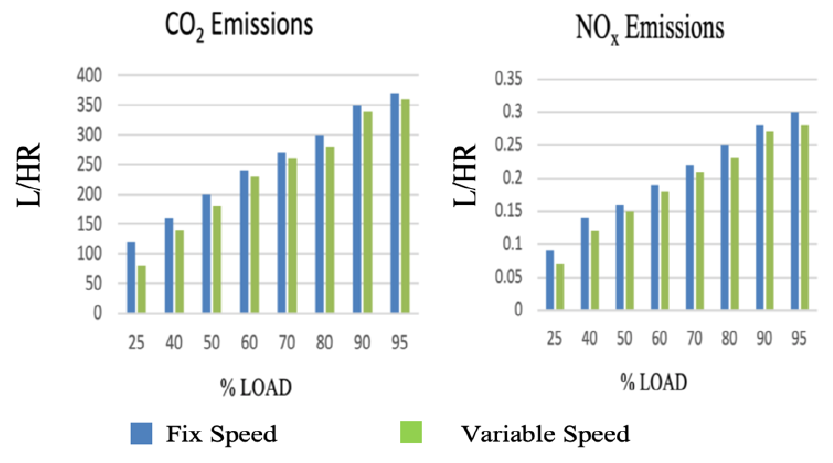
Figure 7. Improved GHG emission at different load levels